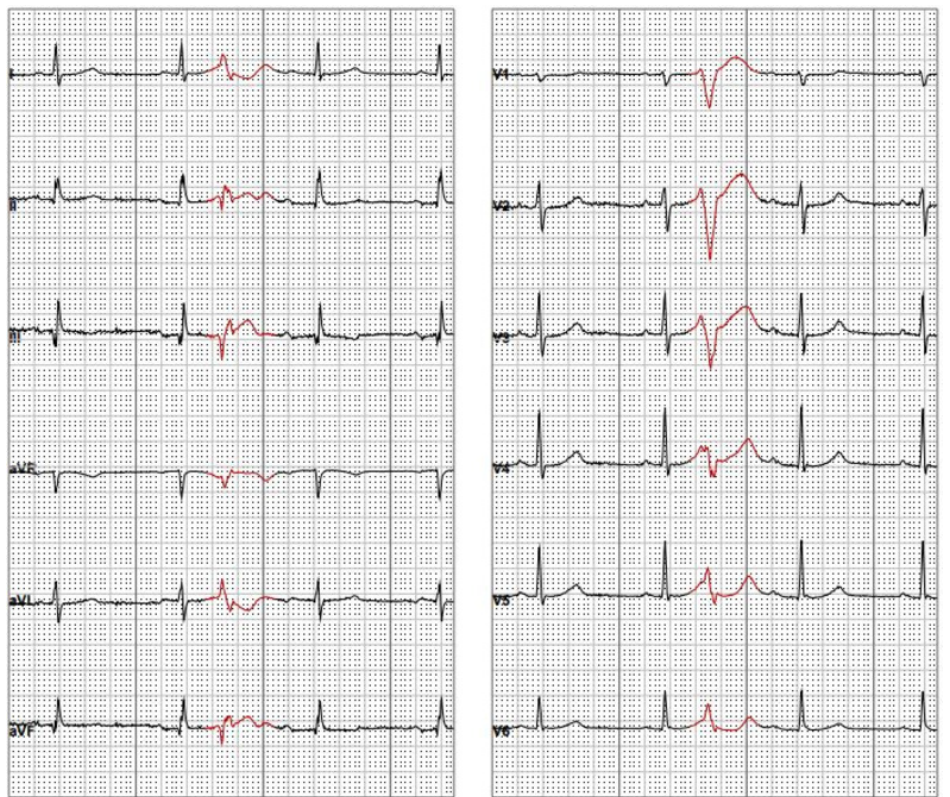
Figure 1. 12-lead electrocardiogram (ECG) with premature ventricular complex (PVC) originating from the right ventricular free wall.